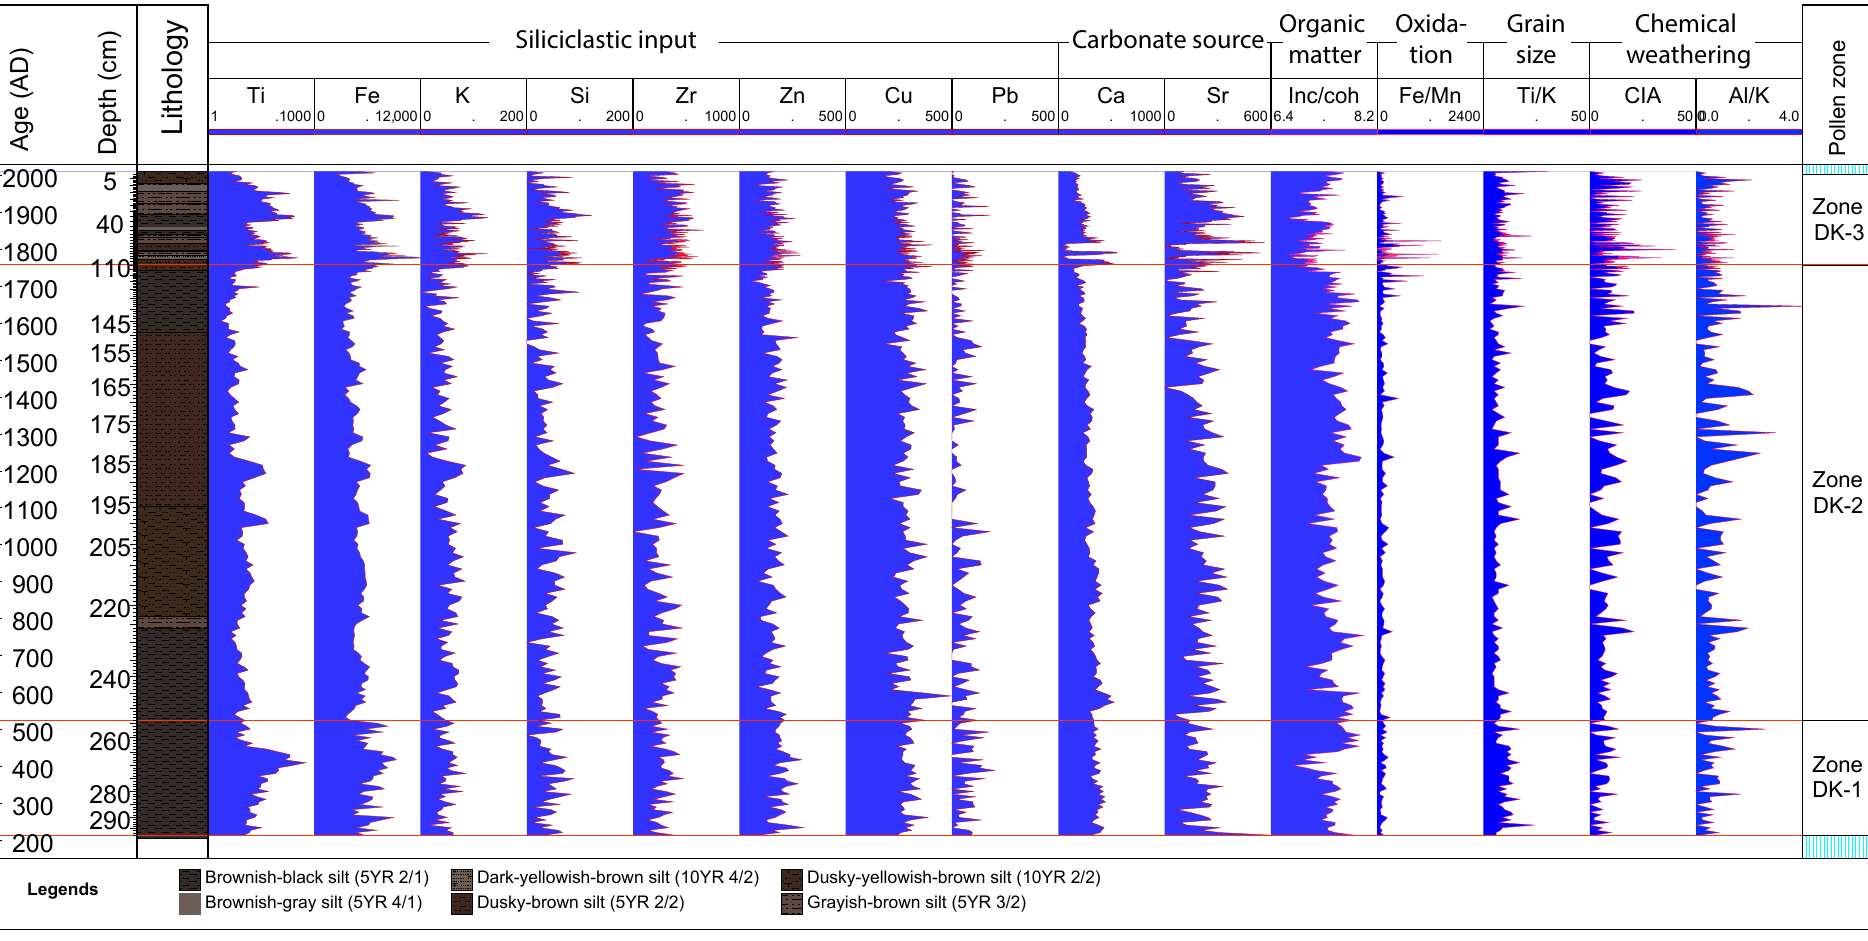
Figure 4. The X-ray fluorescence scanning diagram for multiple elements measured in the DK core. Each element’s value is expressed as counts per second